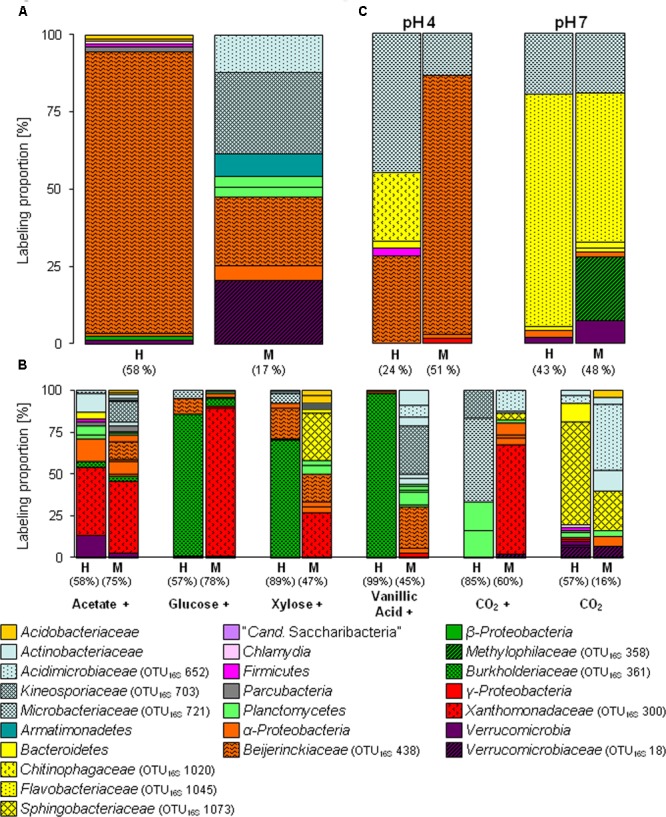
Labeling proportions (LPs) and identities of bacterial 16S rRNA phylotypes in the ‘heavy’ and ‘middle’ fractions of [13C1]-methanol (A) and [13Cu]-substrates (B) treatments of the substrate SIP experiment, and treatments of the pH SIP experiment (C). Cross, additional [12C]-methanol supplementation in substrate treatments. Equal colors, the same phylum affiliation. ‘H’ and ’M,’ ‘heavy’ and ‘middle’ fractions, respectively. Values in brackets, contribution of labeled phylotypes to the total number of sequences. The ‘labeling proportions’ are indicators for the relative importance of different taxa assimilating the supplemented 13C (directly or indirectly). More detailed taxonomic information can be found in Supplementary Tables S16, S17.